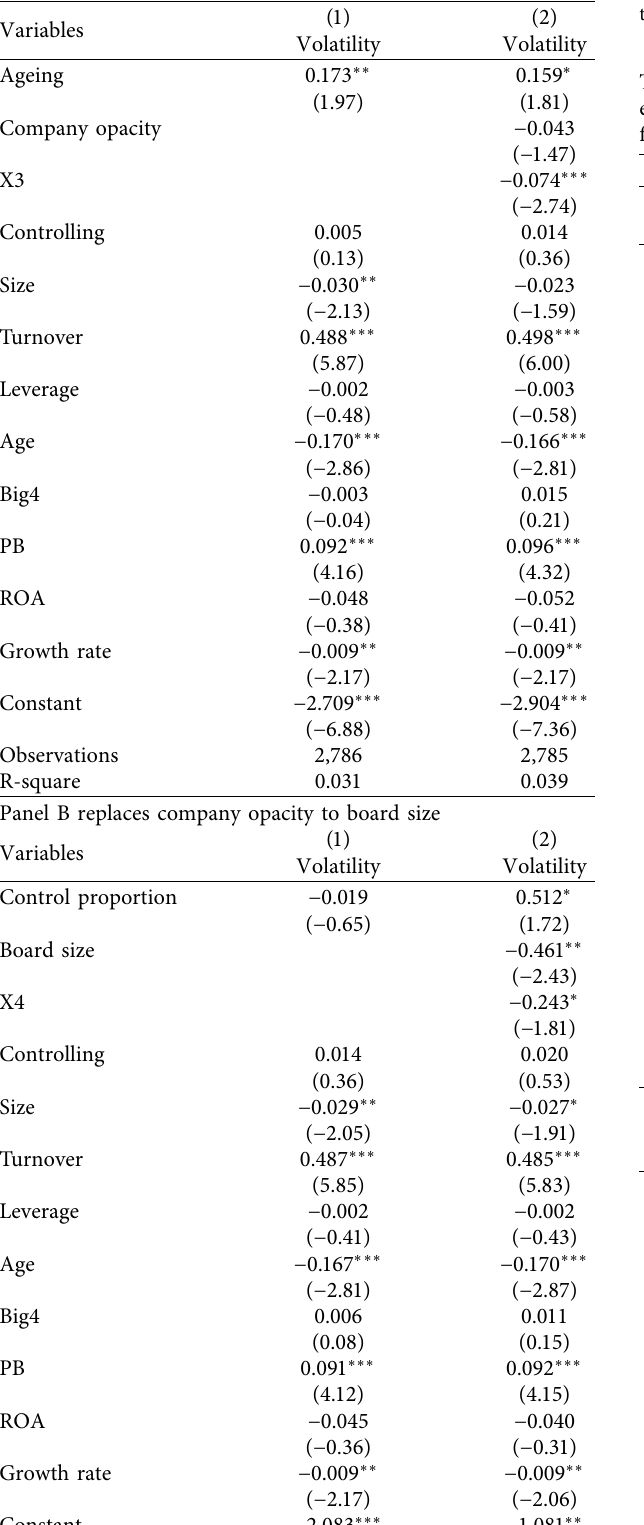
Table 7: The endogeneity checks using Panel A and Panel B to show the results after replacing two explanatory variables, re- spectively. The cross term X1 becomes X3 and X4, respectively.